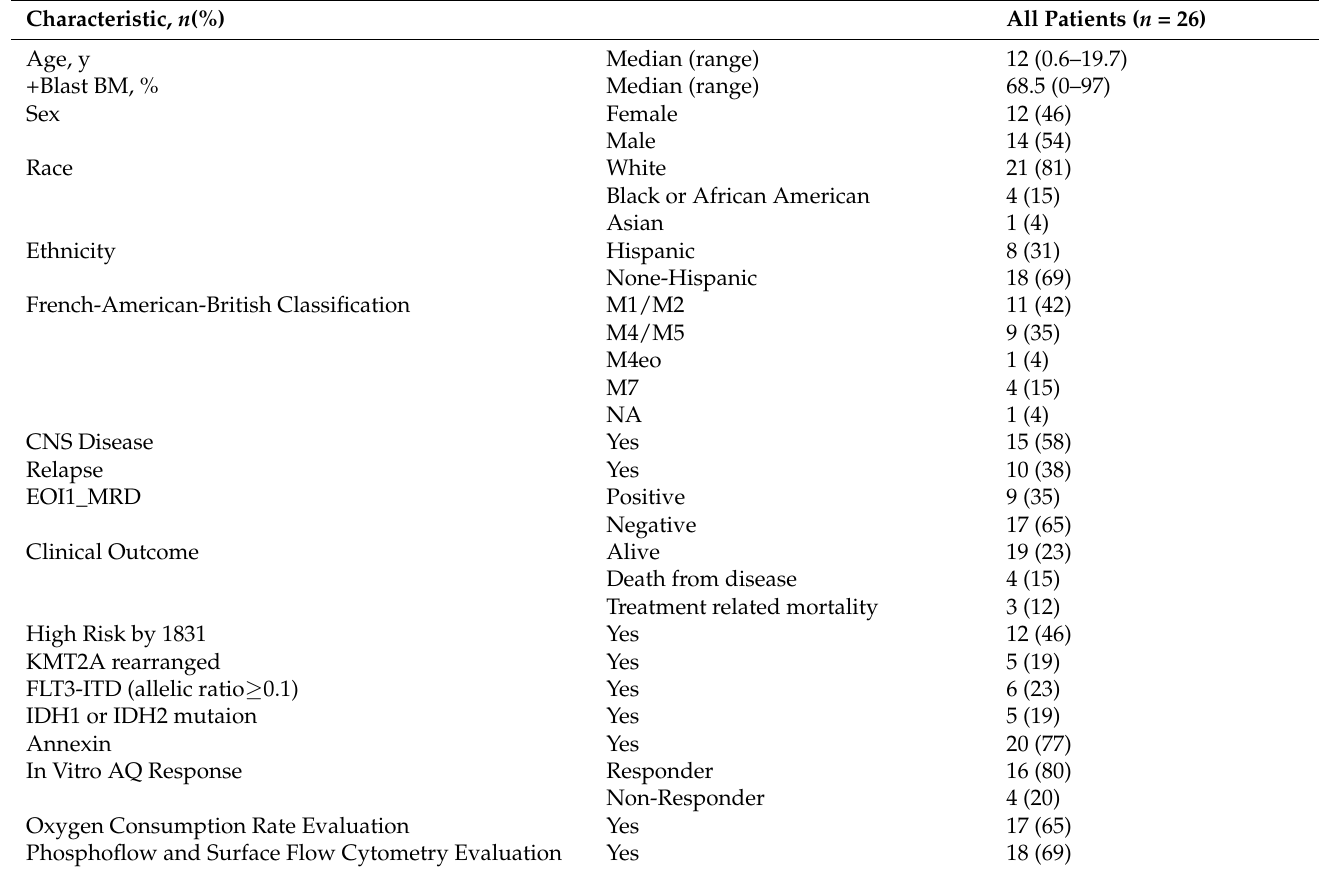
Table 1. Patient demographic and correlative biology